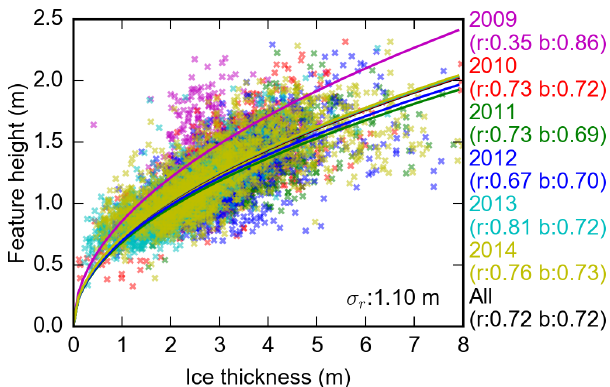
Figure 12. Correlation between the mean IceBridge sea ice thick- ness and surface feature height h f , averaged over 10km along-track sections. The solid lines represent the least-squares fit, assuming √ H i ), where b is the calculated a square-root relationship ( h f = b regression coefficient, and r is the correlation coefficient for all years of data. σ r is the standard error of the residuals (or root mean squared error) calculated using all years of